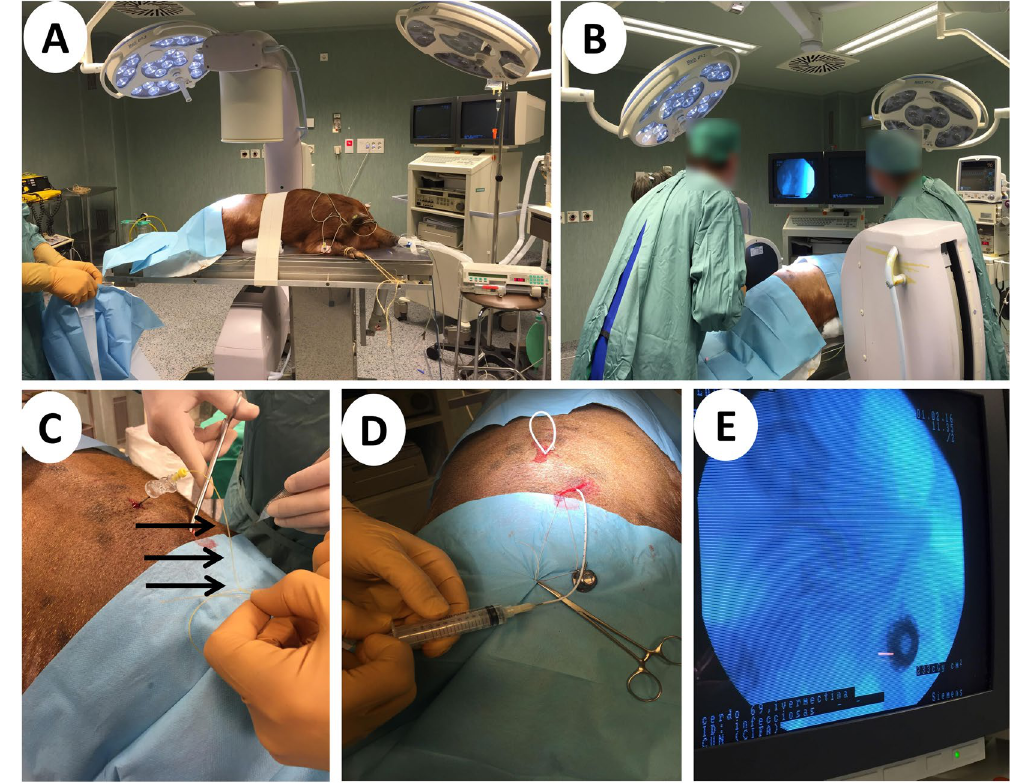
Figure 5. Cerebrospinal fluid sampling. ( A ) The pigs were sedated with tiletamine-zolazepan, intubated and maintained with inhalatory isoflurane. ( B ) Lateral lumbar puncture was performed in aseptic conditions by an anaesthetist and an interventional radiologist under fluoroscopic guidance. ( C ) After introduction of the intrathecal catheter (black arrows), it was tunnelled ( D ) and connected to a reservoir placed in subcutaneous tissue ( E ) to avoid a second round of laborious localization of the intrathecal